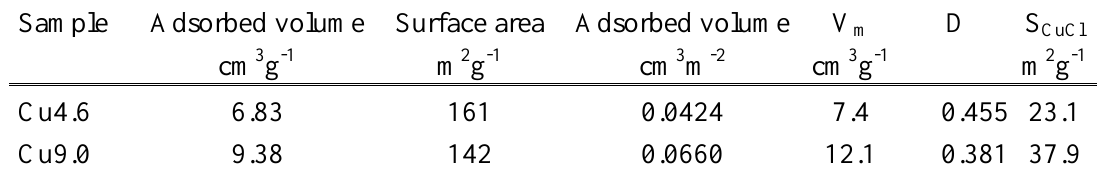
Table 1 . Volume of CO adsorbed at 308 K and 500 Torr and results of static-volumetric